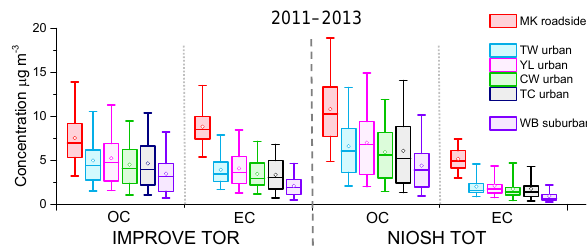
Figure 2. Three-year distributions of OC and EC concentrations by IMPROVE TOR and NIOSH TOT protocols for six sites in Hong Kong. The symbols in the boxplots represent the average (open circles), median (interior lines), 75th and the 25th percentile (box boundaries), and 95th and 5th percentile